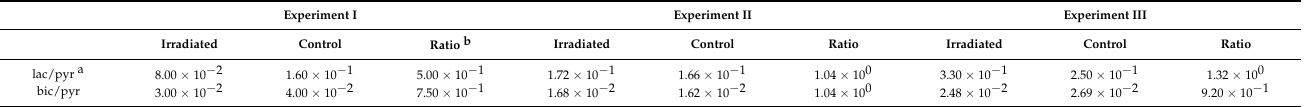
Figure 5. The in vitro metabolite processed signal comparison between the irradiated and control groups: ( a ) lactate signal in the irradiated (blue) and control (orange) groups; ( b ) alanine signal in the irradiated (blue) and control (orange) groups; ( c ) bicarbonate signal in the irradiated (blue dots) and control (orange) groups; and ( d ) aspartate signal in the irradiated (blue dots) and con-trol (orange) groups. Table 3. FaDu cell medium NMR Results.